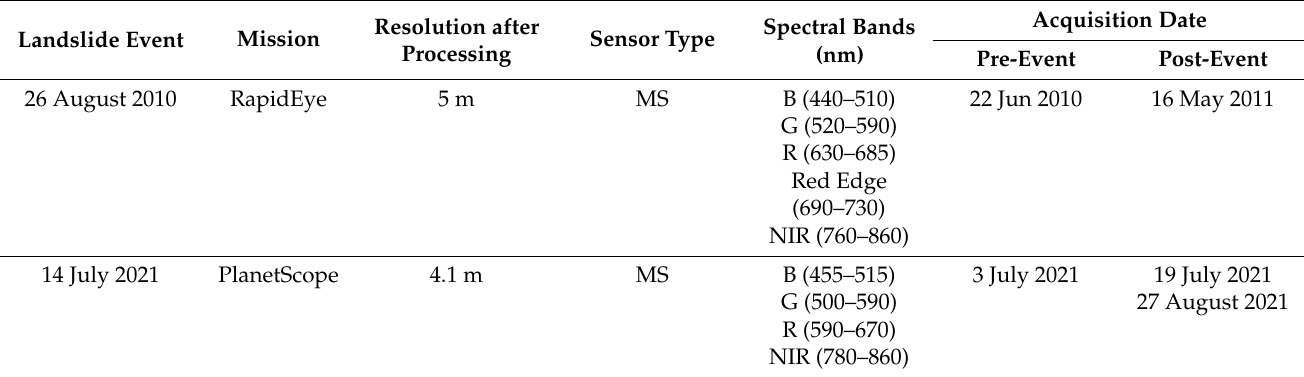
Table 1. Satellite data used for landslide detection and land use